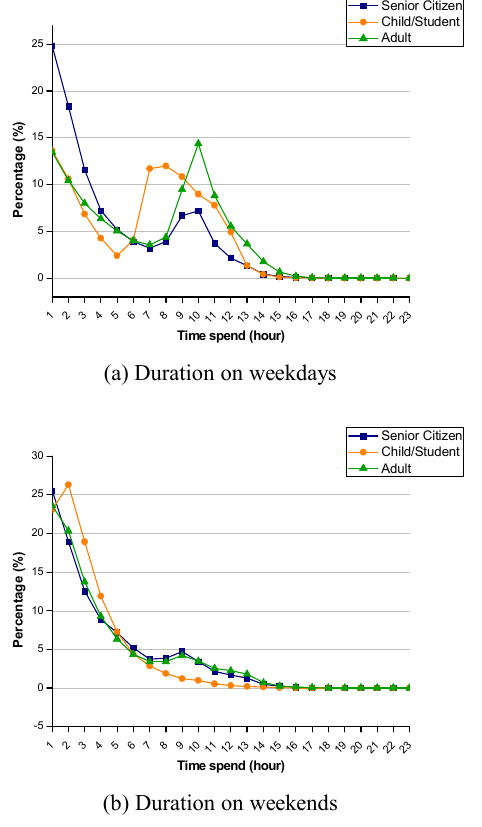
Figure 3. Percentage of duration for an activity in one location